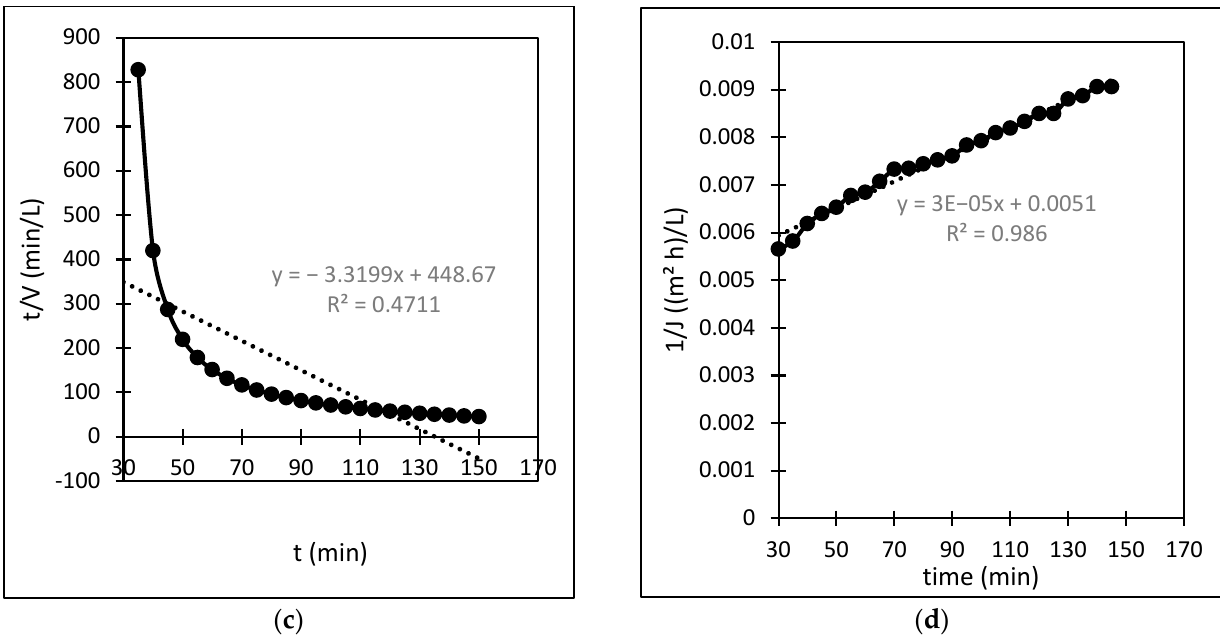
Figure 10. ( a ). Linearised graph representing complete blocking; ( b ) linearised graph representing cake fi ltration; ( c ) linearised graph representing standard blocking; and ( d ) linearised graph representing intermediate blocking.